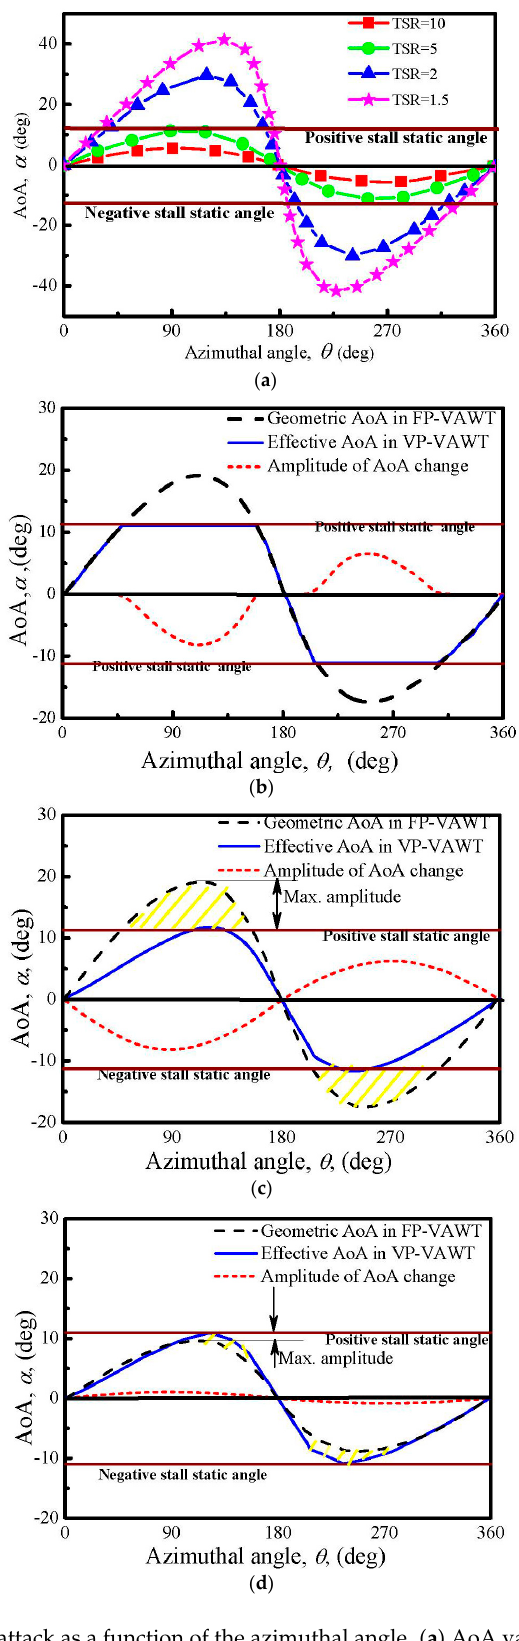
Figure 5. Local angle of attack as a function of the azimuthal angle. ( a ) AoA variation at different TSRs; ( b ) one pitching method at low TSR; ( c ) another pitching method at low TSR; ( d ) pitching method at rated TSR or higher TSR.